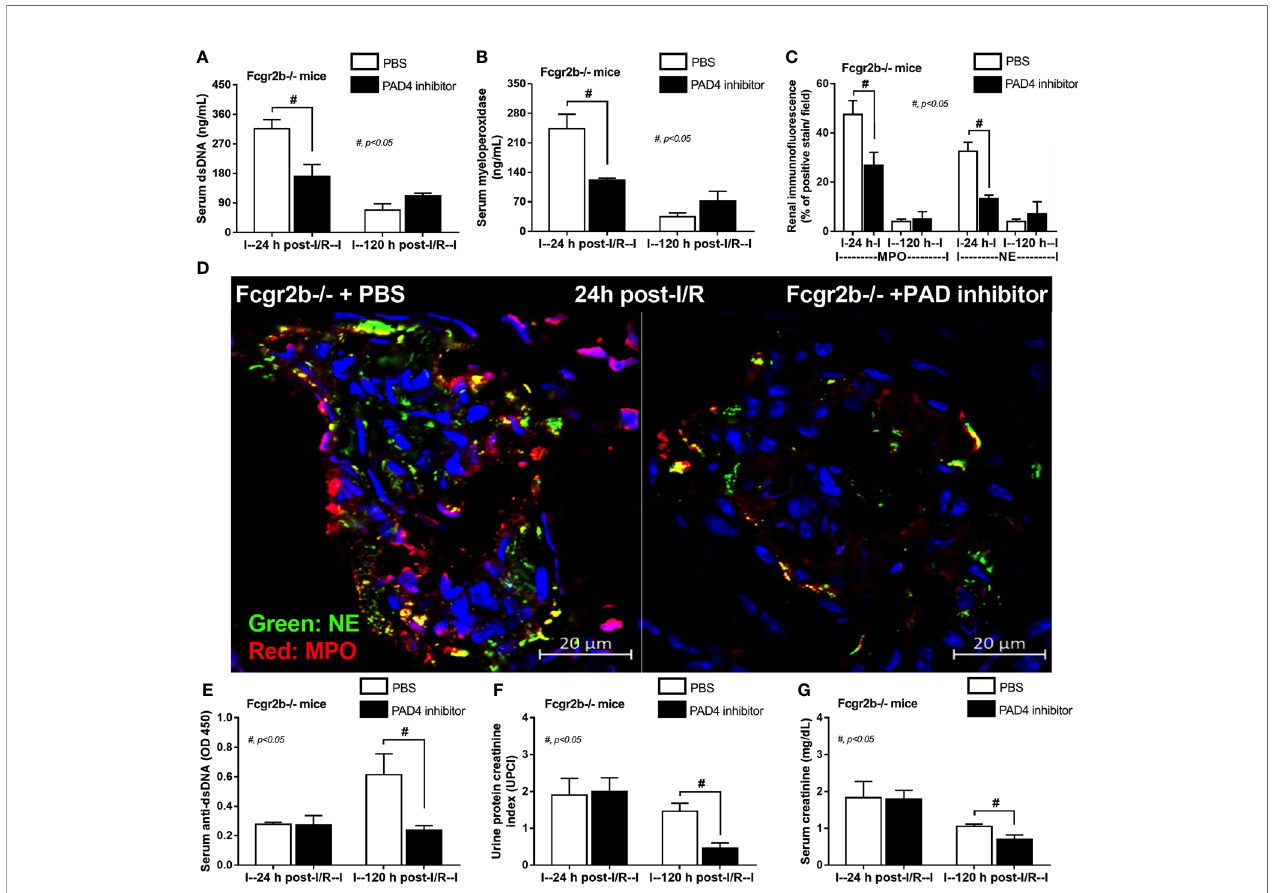
FIGURE 11 | Peptidylarginine deiminase 4 (PAD4) inhibitor decreased neutrophil extracellular traps (NETs) at 24 h after renal ischemia reperfusion injury (I/R) and attenuated lupus characteristics (anti-dsDNA, glomerular immunoglobulin deposition and lupus nephritis) at 120 h post-I/R in lupus prone mice. Characteristics of Fcgr2b-/- mice after renal I/R with PAD4 inhibitor or phosphate buffer solution (PBS) as determined by indicators of NETs in serum; serum dsDNA and serum myeloperoxidase (MPO) (A, B) , NETs in kidneys; co-staining of MPO and neutrophil elastase (NE) with the representative pictures (C, D) and characteristics of lupus nephritis; serum dsDNA, proteinuria (urine protein creatinine index; UPCI), and serum creatinine (E – G) are demonstrated (n = 4 –